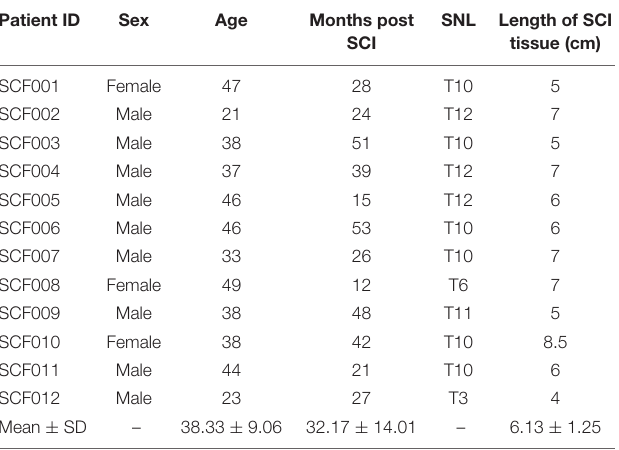
TABLE 1 | Clinical characteristics of the patients.